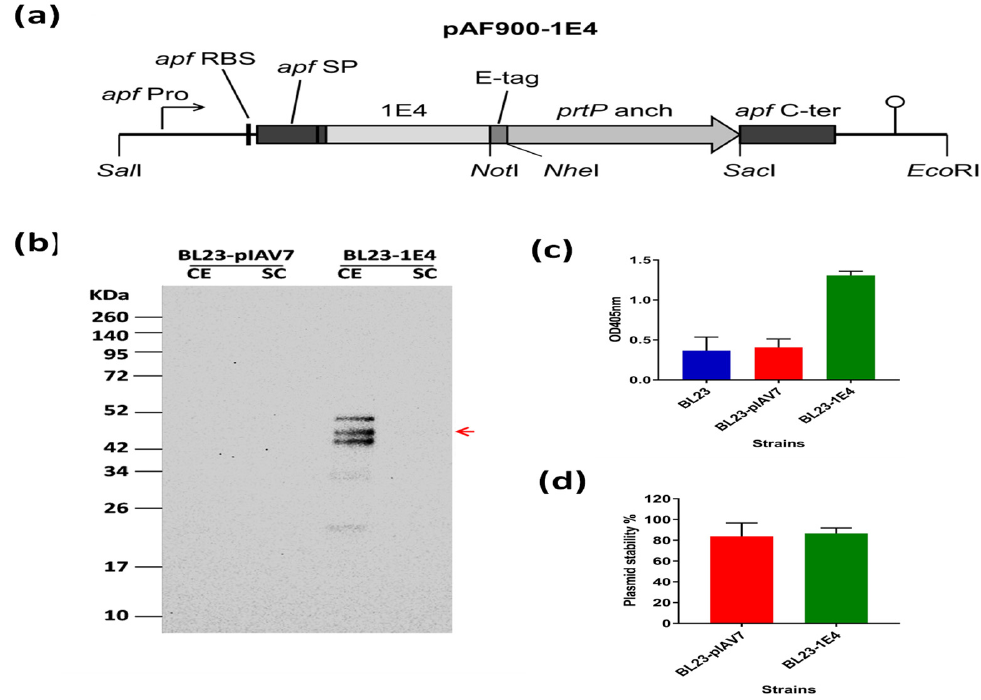
Figure 1. Production of VHH 1E4-displaying Lactobacillus. ( a ) Diagram of the expression cassette (pAF900-1E4) for cell-surface display of 1E4. VHH on L. paracasei BL23. apf Pro, the promoter of apf gene from L. crispatus M247; apf RBS, ribosomal binding site of apf gene; apf SP, the signal peptide of apf gene; prtP anchor, the 243 C-terminal amino acids of prtP from L. paracasei BL23; apf C-ter, C- terminal part of apf gene (not translated). The transcriptional terminator is indicated as the stem- and-loop structure. ( b ) Production of VHH 1E4 in cell extract (CE) and culture supernatant (SC) of cell wall-anchored recombinant L. paracasei BL23 strains tested by Western blotting using monoclonal mouse anti-E-tag antibody and horseradish peroxidase-labeled goat anti-mouse antibody as primary and secondary antibodies, respectively. Lactobacillus paracasei BL23 cells transformed with the empty vector pIAV7 were used as a negative control. The red arrow indicates the band corresponding to VHH 1E4 fused to the cell wall anchor region of PrtP. ( c ) Cell surface display of VHH 1E4 in recombinant L. paracasei BL23 strains according to ELISA assay using bacterial suspensions, a monoclonal mouse anti-E-tag antibody as the primary antibody, and alkaline phosphatase-conjugated rabbit anti-mouse antibody as the secondary antibody. Non- transformed L. paracasei BL23 cells and the strain transformed by the empty vector pIAV7 were used as negative controls. Signals were detected by reading the absorbance at 405 nm. The experiment was performed twice, and results are expressed as mean ± 1 standard deviation (SD). ( d ) Plasmid persistence of the recombinant L. paracasei BL23 strains expressing VHH 1E4 (BL23-1E4), measured according to colony count assays. The experiment was performed twice, and results are expressed as mean ± 1 SD. hpi, hours post-inoculation.